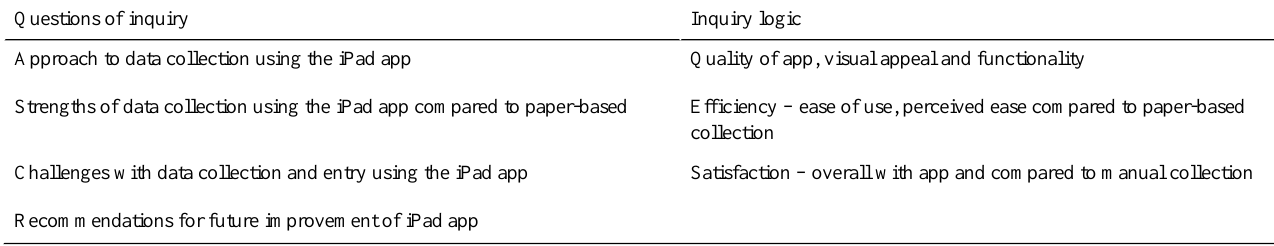
Table 1. Interview questions asked from field workers and the focus of inquiry for process